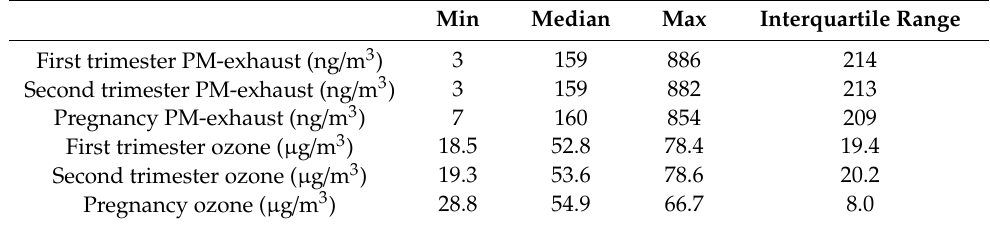
Table 1. Summary table of the distribution of air pollution